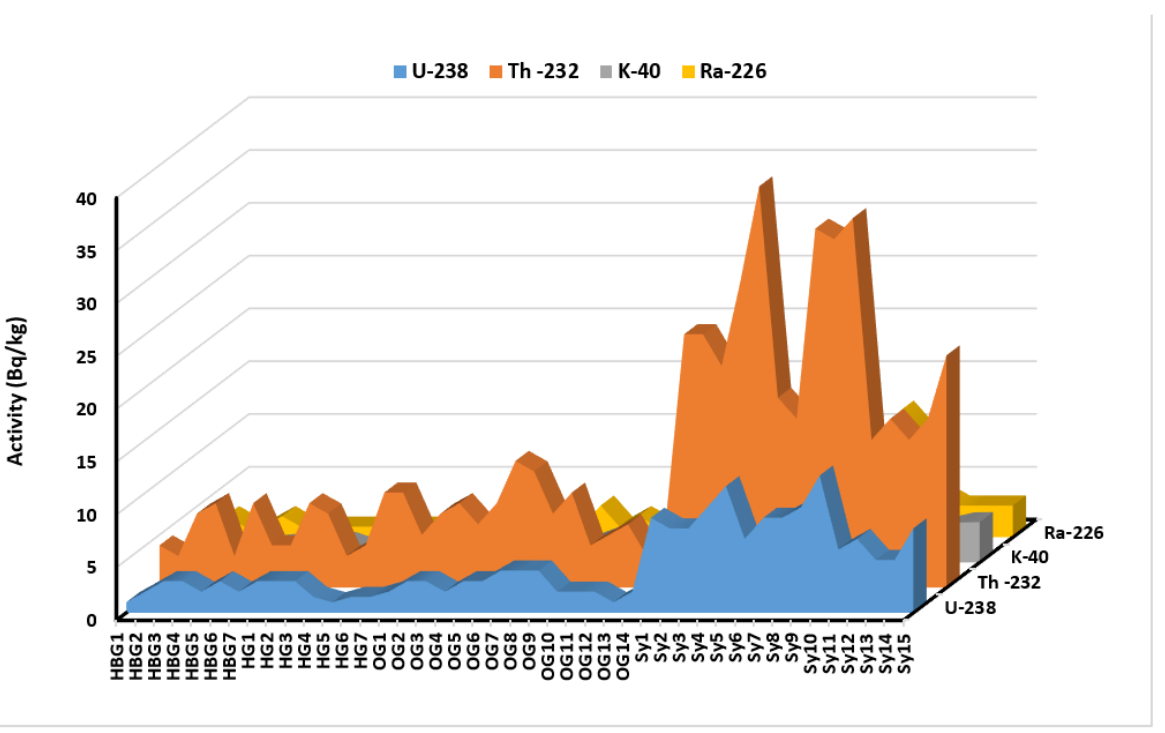
Figure 3. Representation of the radiometric measurements of 238 U, 226 Ra, 232 Th, and 40 K (ppm) in the samples of Seih-Sidri area, Egypt. Table 1. Average, minimum (Min), and maximum (Max) radiometric measurements of the studied rocks in the study area.